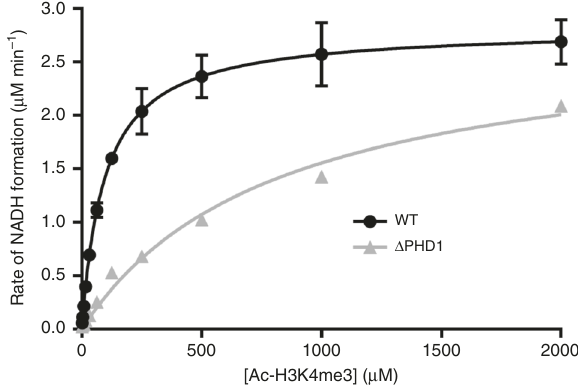
Fig. 5 Deletion of the PHD1 domain impairs substrate binding by KDM5A. Michaelis – Menten plot for demethylation of Ac-H3K4me3 21mer substrate by KDM5A 1-797 and KDM5A 1-797 Δ PHD1 determined by the formaldehyde release assay where Ac-H3K4me3 21mer peptide was used as a substrate. Data are fi tted to the Michaelis – Menten equation. Kinetic parameters are show in Table 3. Errors ( n ≥ 3) represent s.e.m.